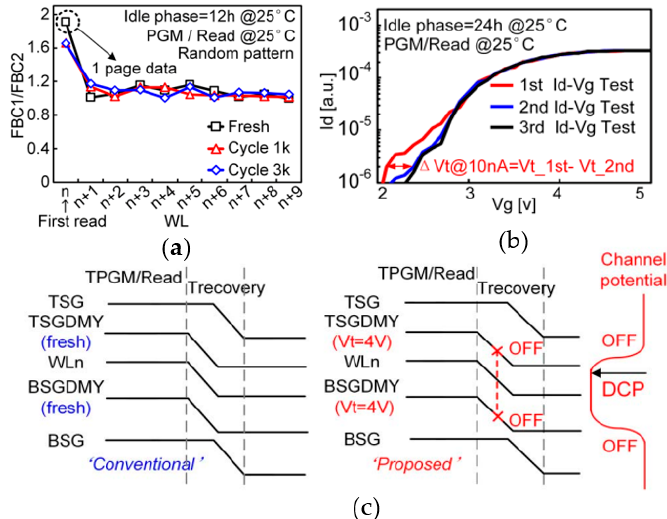
Figure 12. ( a ) Experimental fail bit count at fresh, after 1 K P/E cycles and 3 K P/E cycles. Reprinted/adapted with permission from Ref. [84], 2021, IEEE. ( b ) Id-Vg sweep with Cell Vt is programmed to ∼ 3 V. Reprinted/adapted with permission from Ref. [84], 2021, IEEE. ( c ) The recovery phase of conventional and proposed program operation, respectively. Reprinted/adapted with permission from Ref. [84], 2021, IEEE.